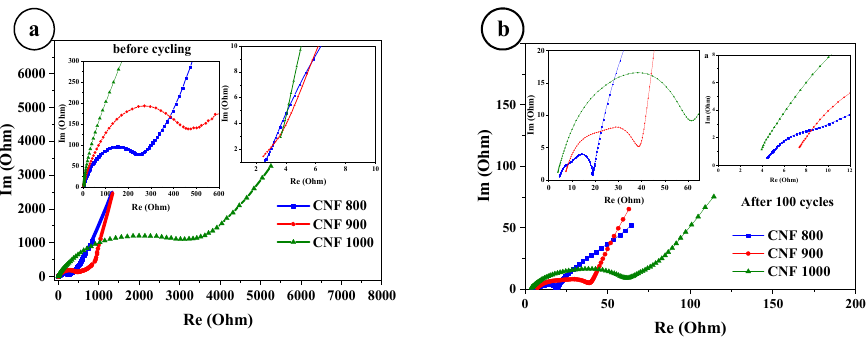
Figure 5. Impedance curves of CNF before, ( a ) and after cycling, ( b ). The Li+ diffusion coefficient of the CNFs is calculated by Formulas (2) and (3) [36]. The relationship between Z’ (real part resistance) and ω (angular frequency) is shown in Figure 6.